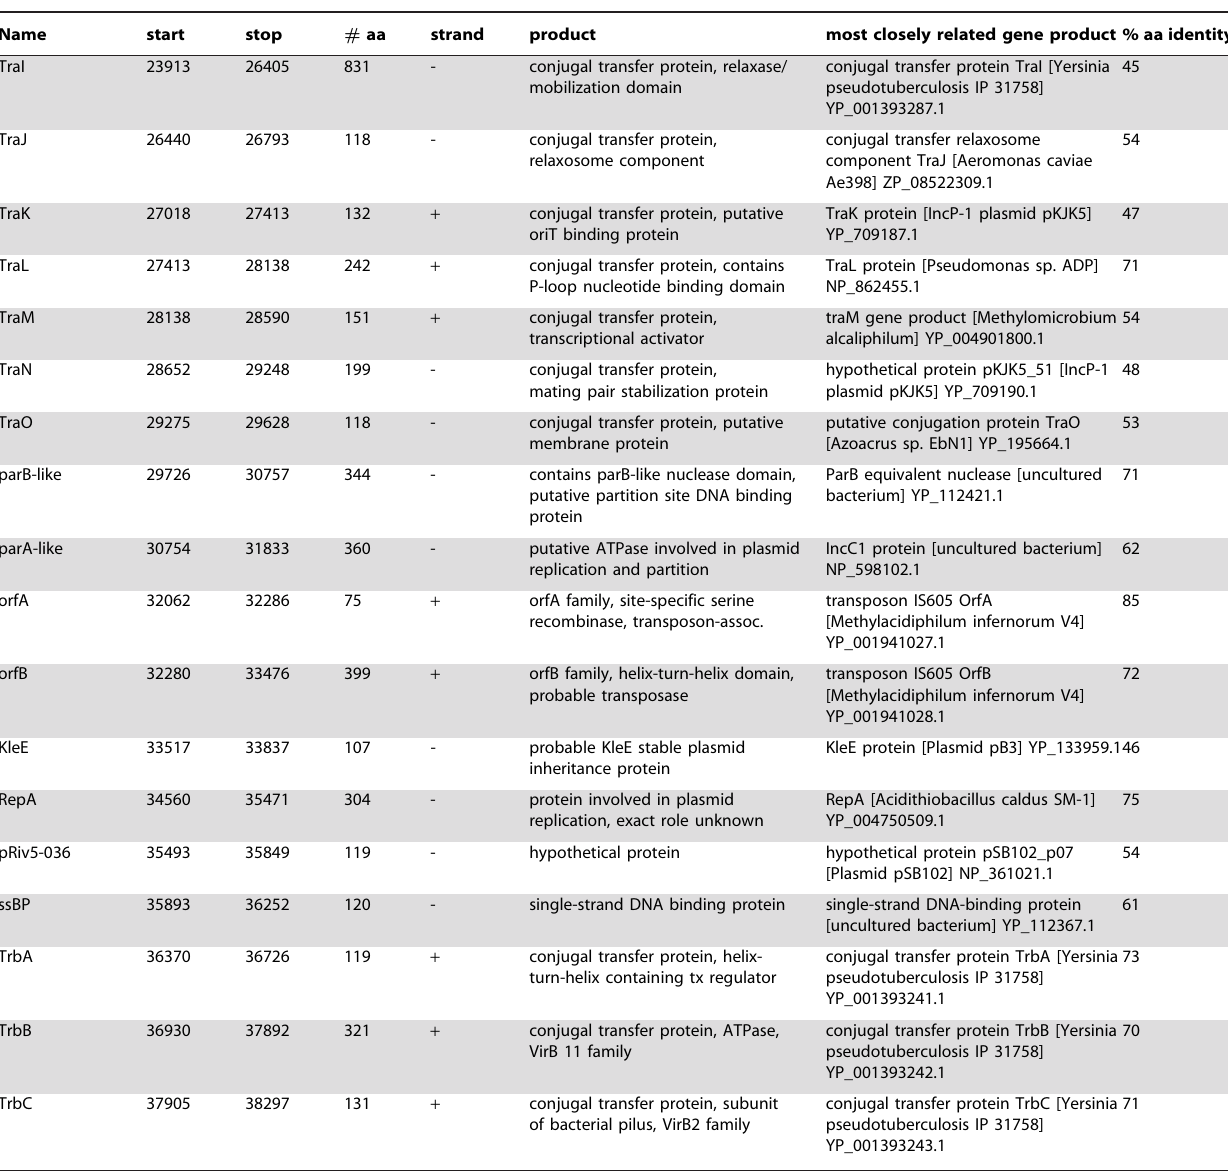
The most closely related gene product was identified using BLAST P and excludes other proteins from X. fastidiosa . doi:10.1371/journal.pone.0052131.t001 environmental samples, no accessory modules containing homo- logues of known virulence factors, antibiotic/heavy metal resis- tance, or catabolism of toxic organic compounds were encoded by pXF-RIV5.